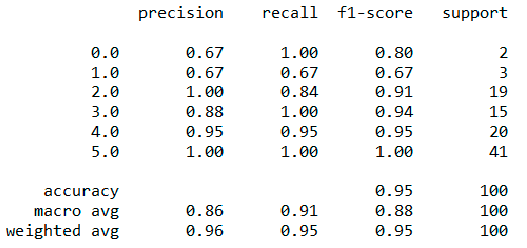
Figure 4. Performance metric of “SVM” classification with 5-fold cross validation.